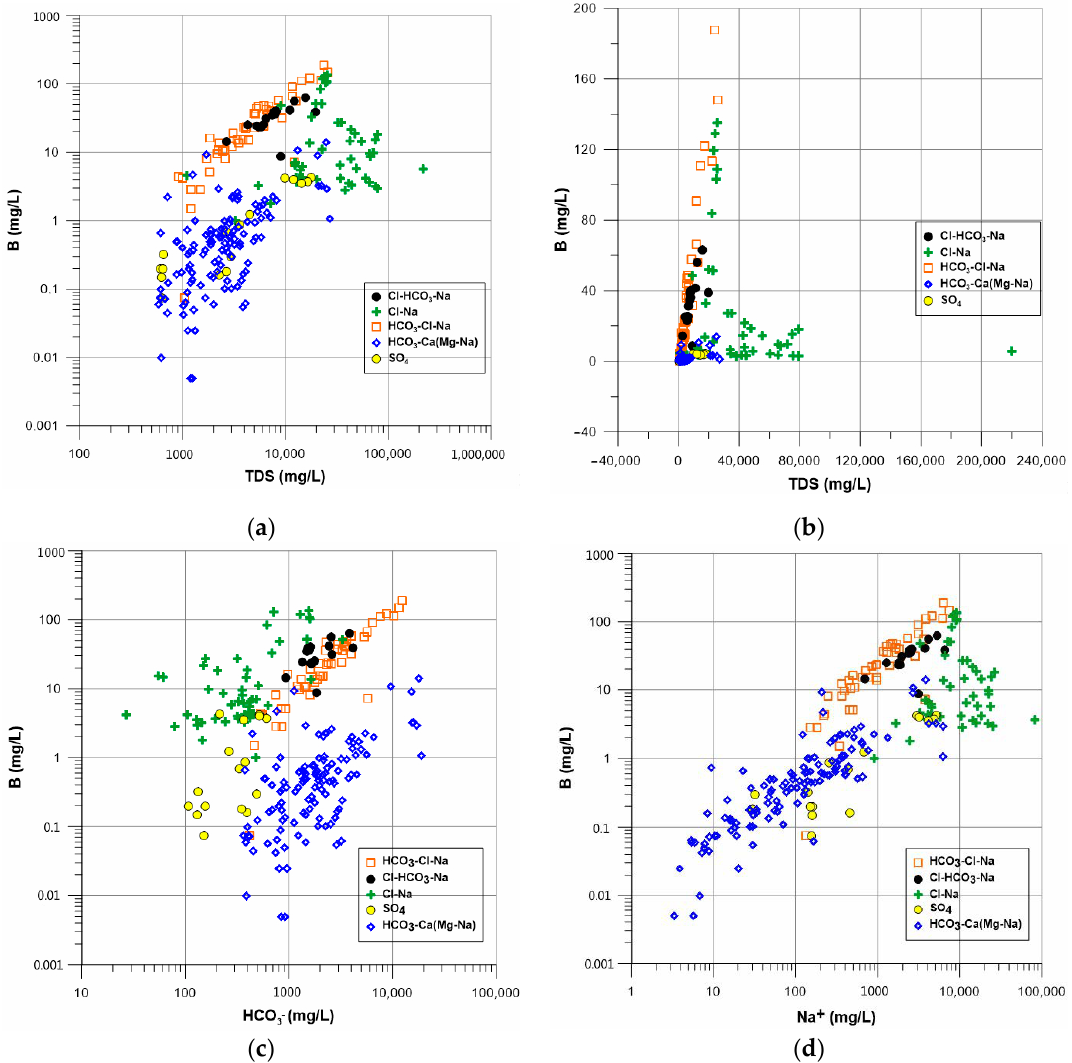
Figure 5. Boron concentration versus: ( a ) the sum of dissolved solids (mineralization of water)—double-logarithmic graph; ( b ) the sum of dissolved solids (mineralization of water)—linear graph; ( c ) HCO 3 − concentration—double-logarithmic graph ( d ) Na + concentration in curative waters—double-logarithmic